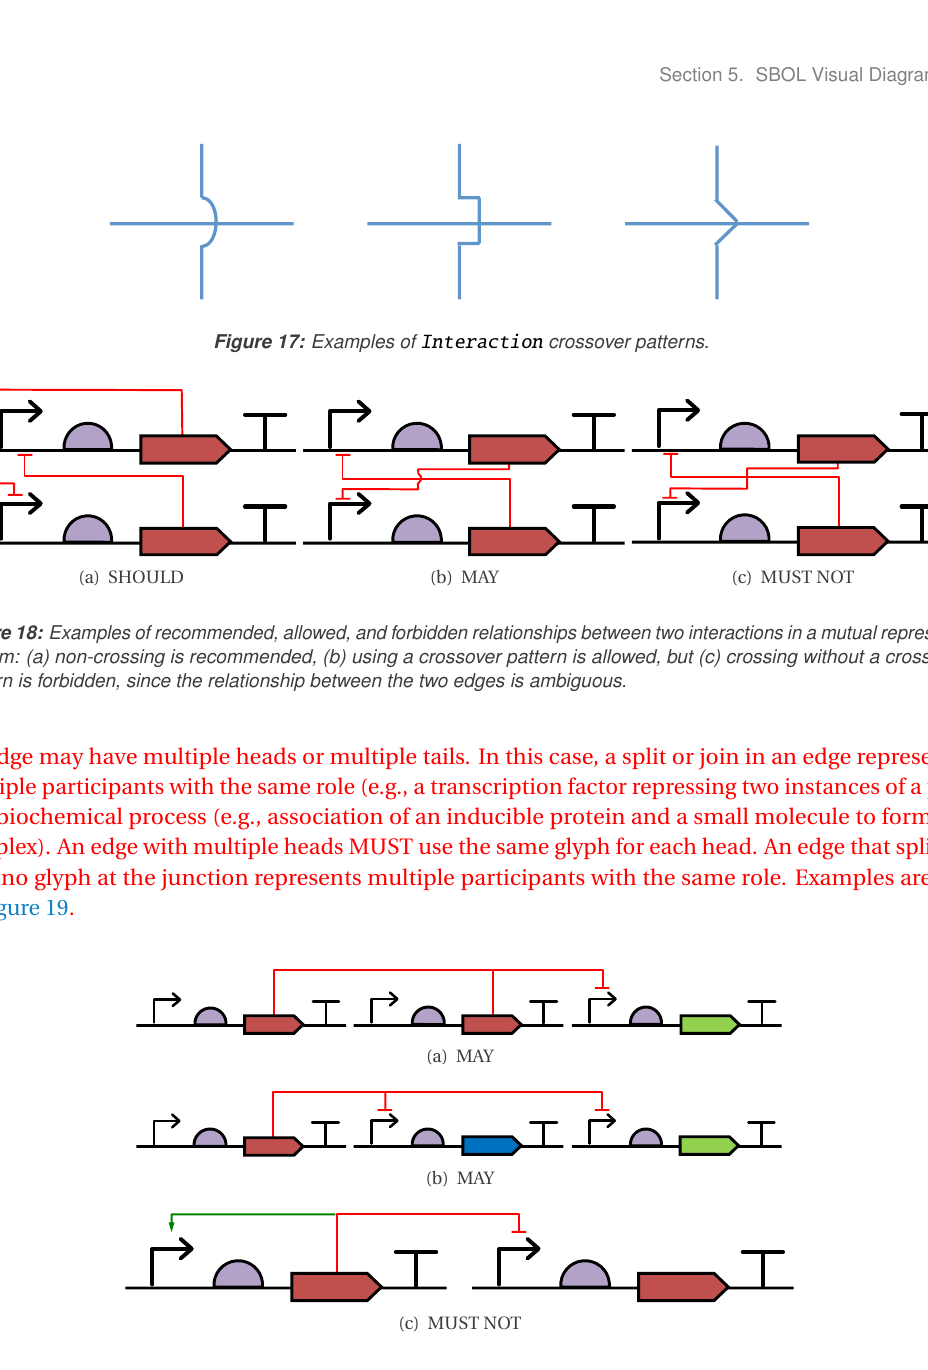
Figure 19: Examples of use of multi-head and multi-tail arrows: (a) Repression from multiple independent sources and (b) repressor with multiple targets. (c) Multi-head interactions, however, MUST NOT use different glyphs for different heads.